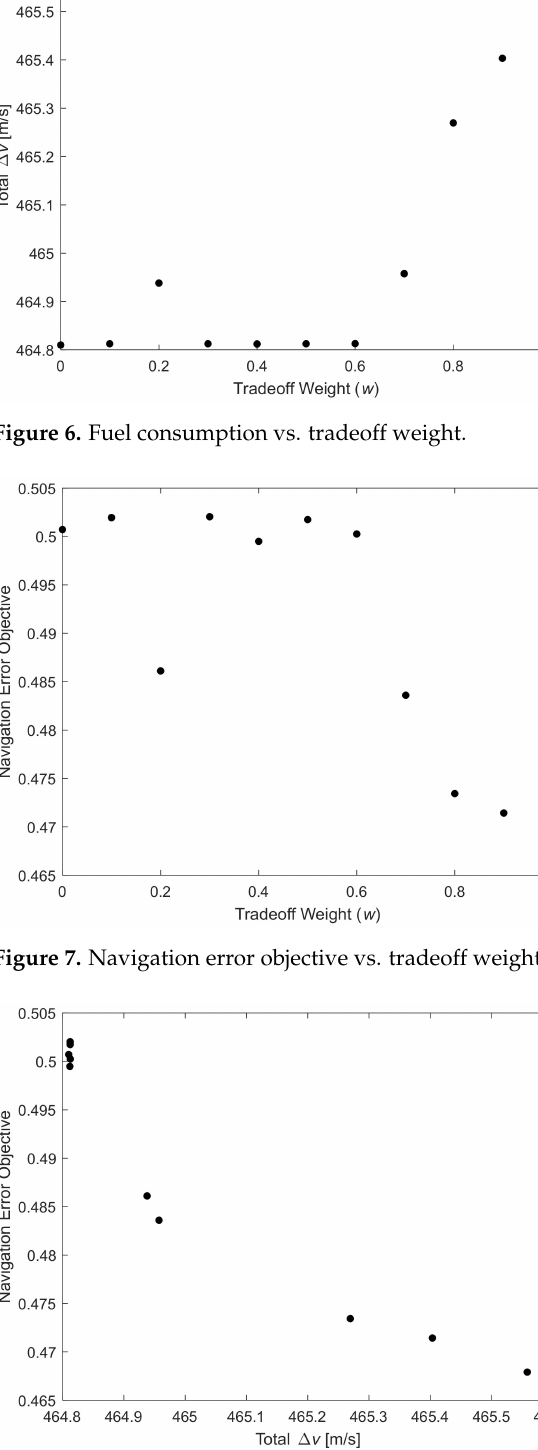
Figure 8. Navigation error objective vs. fuel